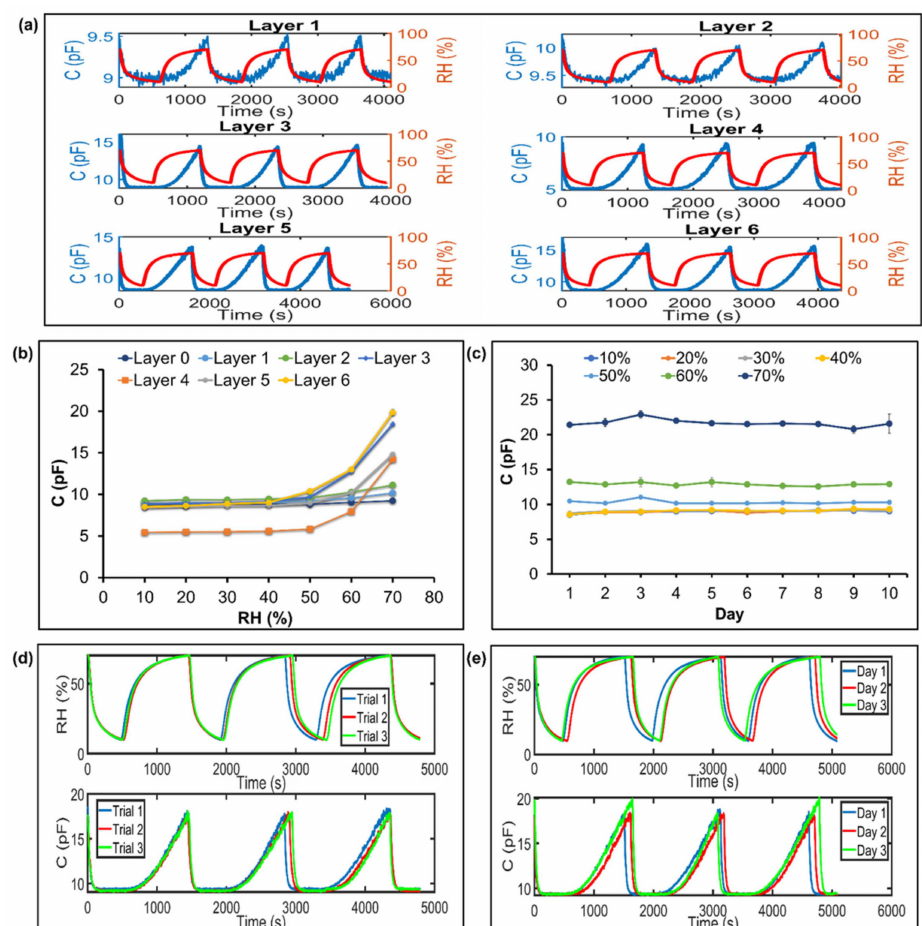
Figure 4. Performance of paper-based Inkjet-printed graphene in humidity sensing. ( a ) Capacitance change in paper sensor with RH change of 10–70%. ( b ) The effect of printing layers on the sens- ing performance of paper at constant RH. ( c ) Stability, ( d ) intraday repeatability, and ( e ) intraday repeatability of paper-based Inkjet-printed graphene in 10–70% RH